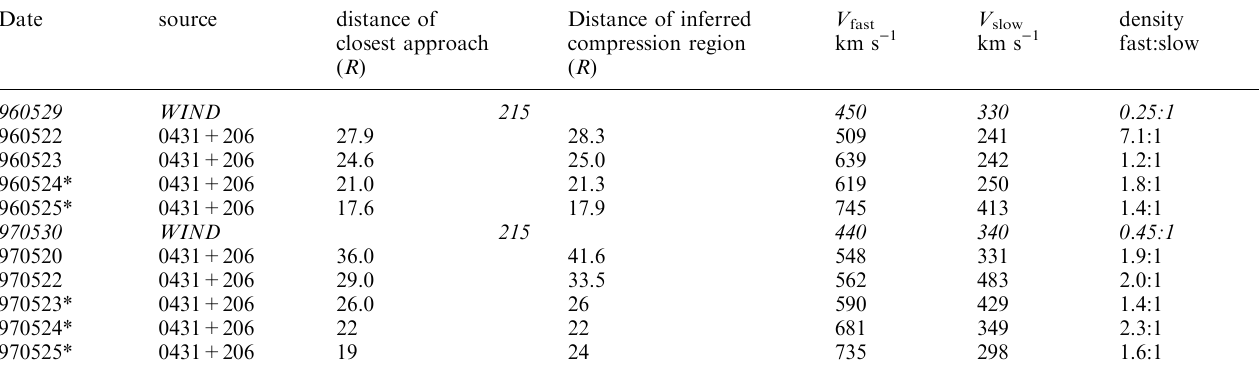
Table 4. Compression regions observed close to the Sun. Asterisks denote observations which include regions dominated by strong scattering. In all cases the ‘‘fast’’ stream density is the